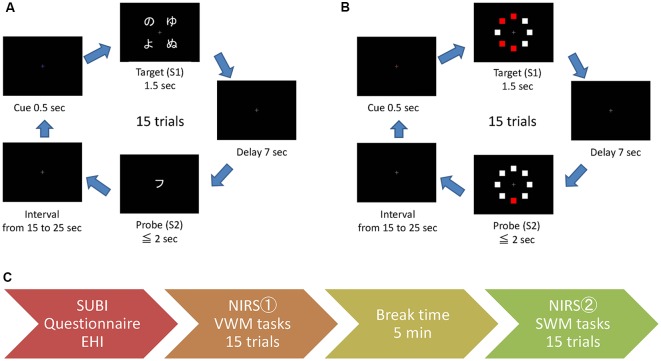
The sequence of working memory tasks and experimental procedure. For the VWM task (A), four Hiragana characters were presented as the target (S1) and a Katakana character was presented as the probe (query) stimulus (S2). For the SWM task (B), eight squares including four red squares were presented as the target (S1) and one red square and seven white squares were presented as the probe (query; S2). The experimental procedure is outlined in the aligned feathered arrow shapes (C). SUBI, Subjective Well-Being Inventory; NIRS, near-infrared spectroscopy.